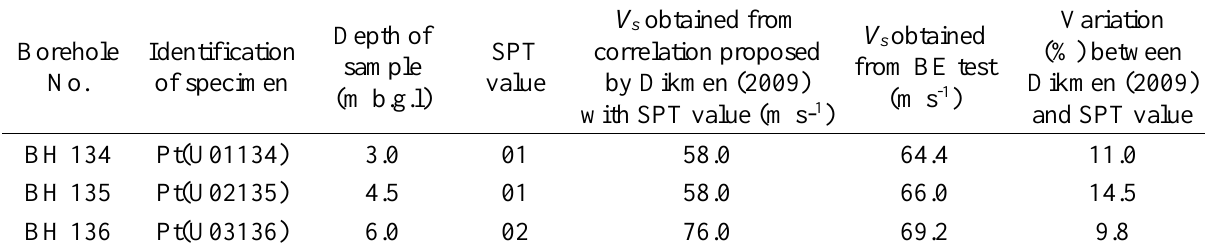
Table 3. Comparison of V s obtained from empirical relationship based on SPT and laboratory at similar effective stress. b.g.l = below ground level, SPT = standard penetration test, V s = shear wave velocity, BE = bender element.